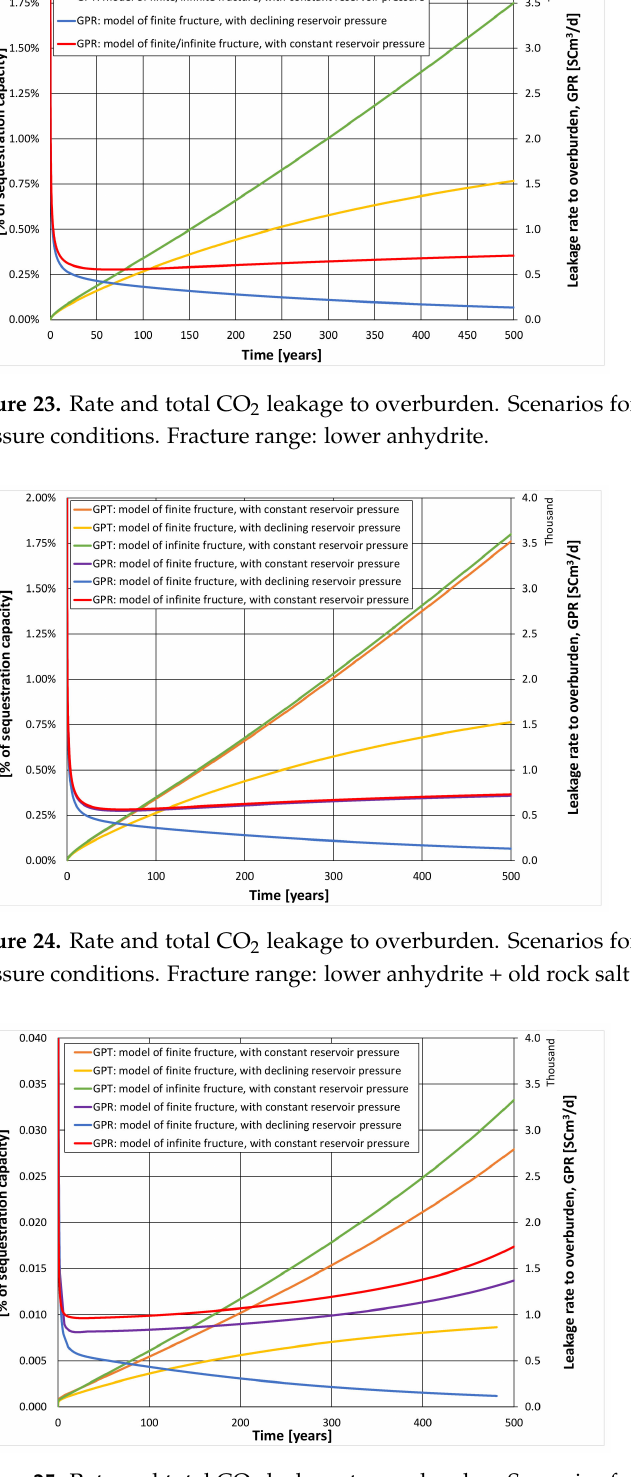
Figure 25. Rate and total CO 2 leakage to overburden. Scenarios for different fracture models and pressure conditions. Fracture range: lower anhydrite + old rock salt + upper